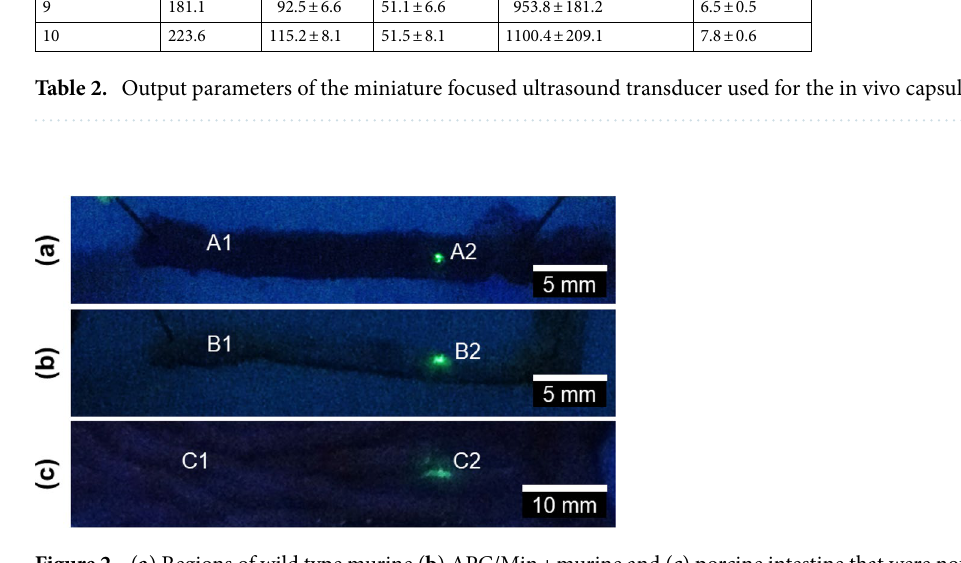
Figure 2. ( a ) Regions of wild type murine ( b ) APC/Min + murine and ( c ) porcine intestine that were not- insonated near the points A1, B1, C1 or insonated near points A2, B2, C2. In all cases tissue was exposed to Quantum dots. Quantum dots were clearly visible only when tissue was insonated near points A2, B2 and C2. Images were taken after